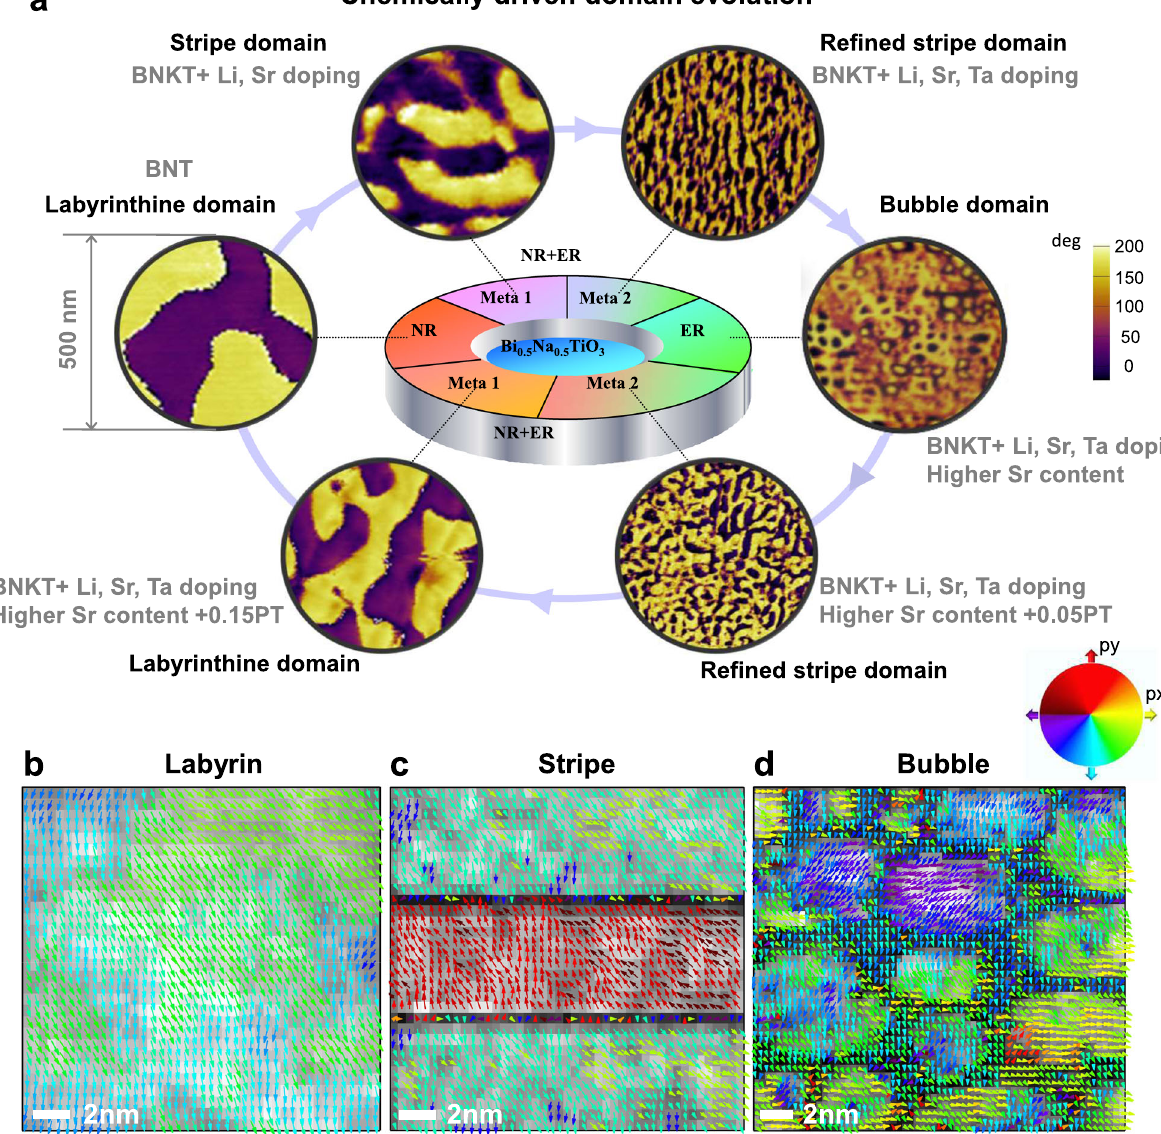
Fig. 1 Observation of bubble domains in bulk ferroelectrics. a Chemically driven reversible domain evolution in bulk Bi 0.5 Na 0.5 TiO 3 -based ferroelectrics. b – d Results derived from atomically resolved STEM ABF (contrast-inverted) images (Supplementary Fig. 7a − c) of BNT-labyrinthine, BNT-stripe, and BNT- bubble samples along [110] pc , with the δ Ti-O displacement vector maps overlaid on their corresponding polarization intensity; the displacement vectors are indicated as colored arrows according to their rotation angles, and the polarization intensity is indicated by bright − dark